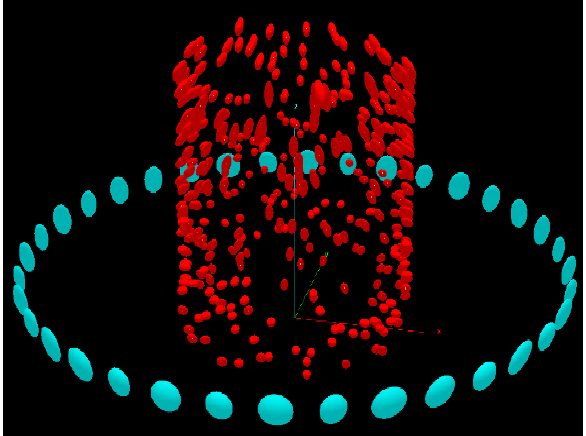
Figure 5. Error ellipsoids in the case of a closed sequence.